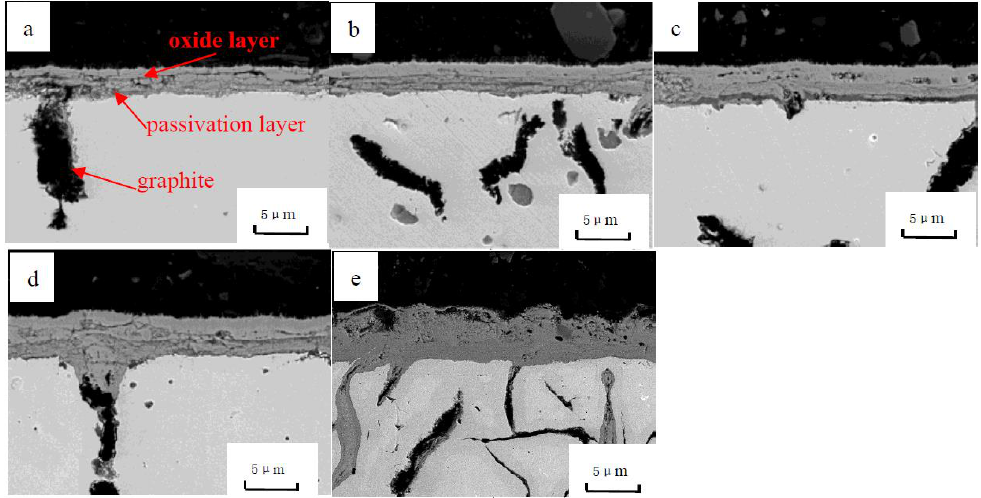
ff erent oxidation